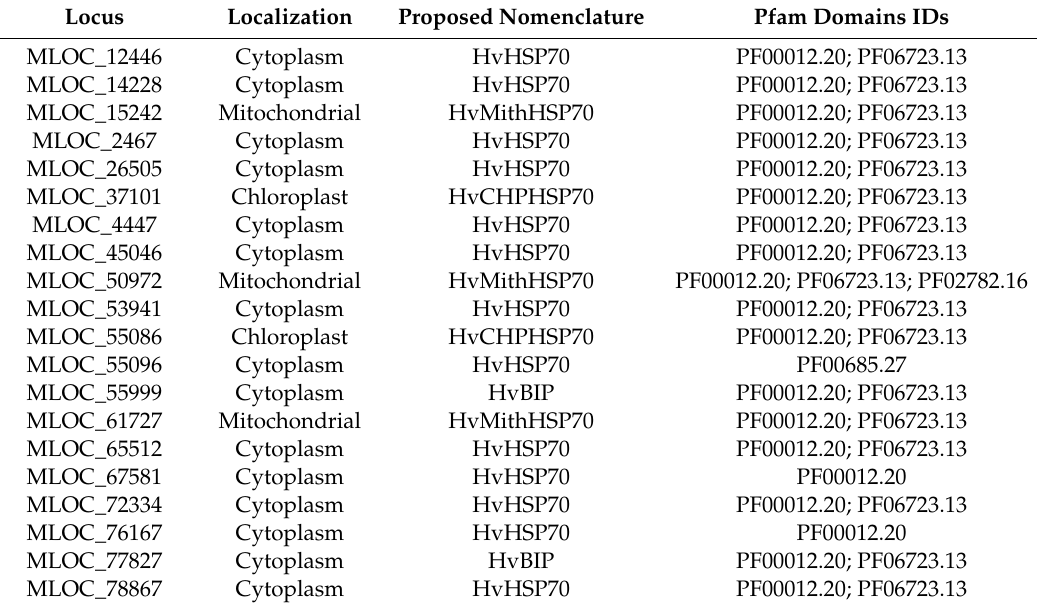
Figure 2. The immunoblotting of leaf extracts from Barley Nure plants exposed to ( A ) salt stress (NaCl); and ( B ) Drought (PEG) collected at given times. In the lane 3ctrl extracts from untreated plants after 3d were loaded. Immunoblotting was performed by using antibodies raised abainst cytosolic (Cy-HSP70); chloroplastic (Chl-HSP70) and mitochondrial (Mito-HSP70). The control blots using anti-tubulin antisera are shown. Table 1. List of identified barley HSP70s, their localization and pfam identified domains.